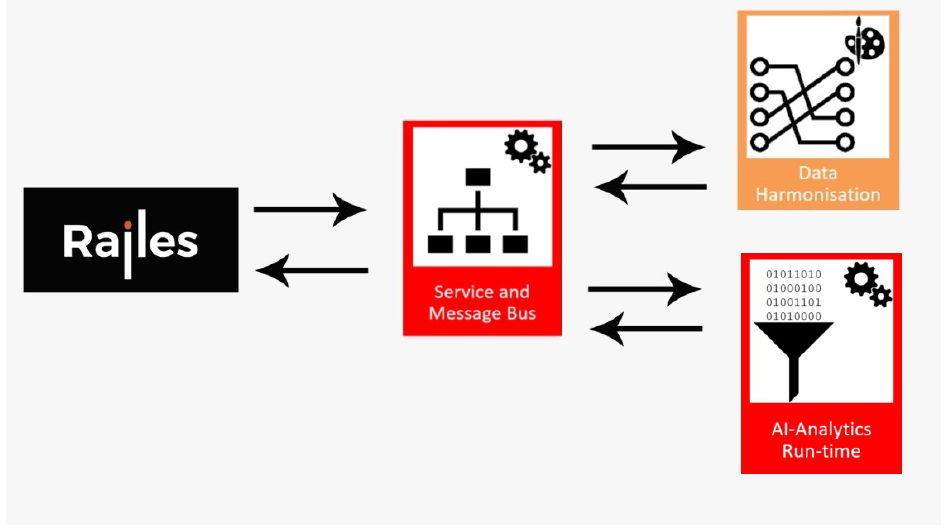
Figure 6. Software architecture.